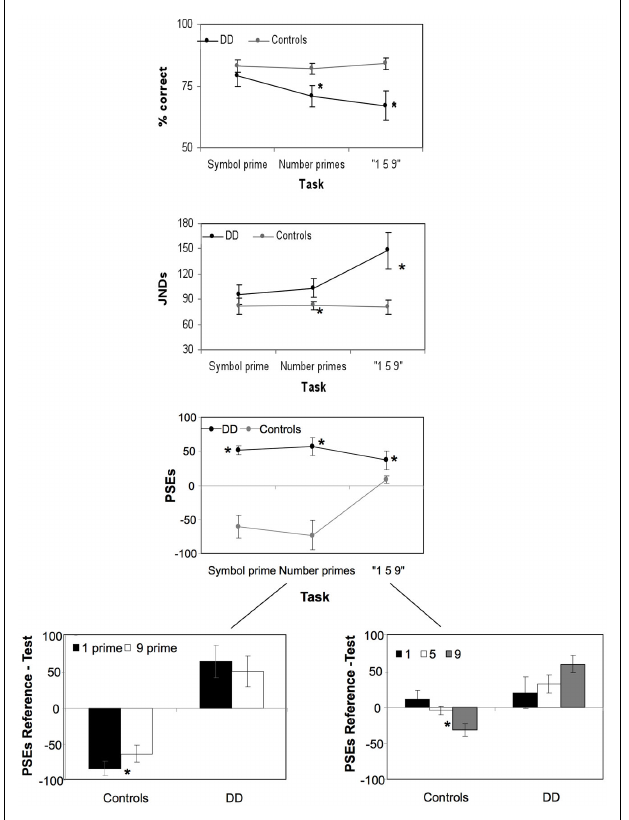
FIGURE 3 | Performance in all experimental conditions and modulation of numerical stimuli in the number prime and the “1–5–9” conditions. Performance in the three time discrimination conditions is described in terms of accuracy, just noticeable difference (JNDs), and point of subjective equality (PSE) for DD and control participants. Asterisk indicate statistical significance for the difference between the two groups of participants or between stimuli (i.e., “1” vs. “9” prime conditions).Values on the y -axis indicate how much longer (positive) or shorter (negative) a stimulus had to be displayed in order to be perceived as different from the reference stimulus (JNDs) or of the same duration of the reference stimulus (PSEs).